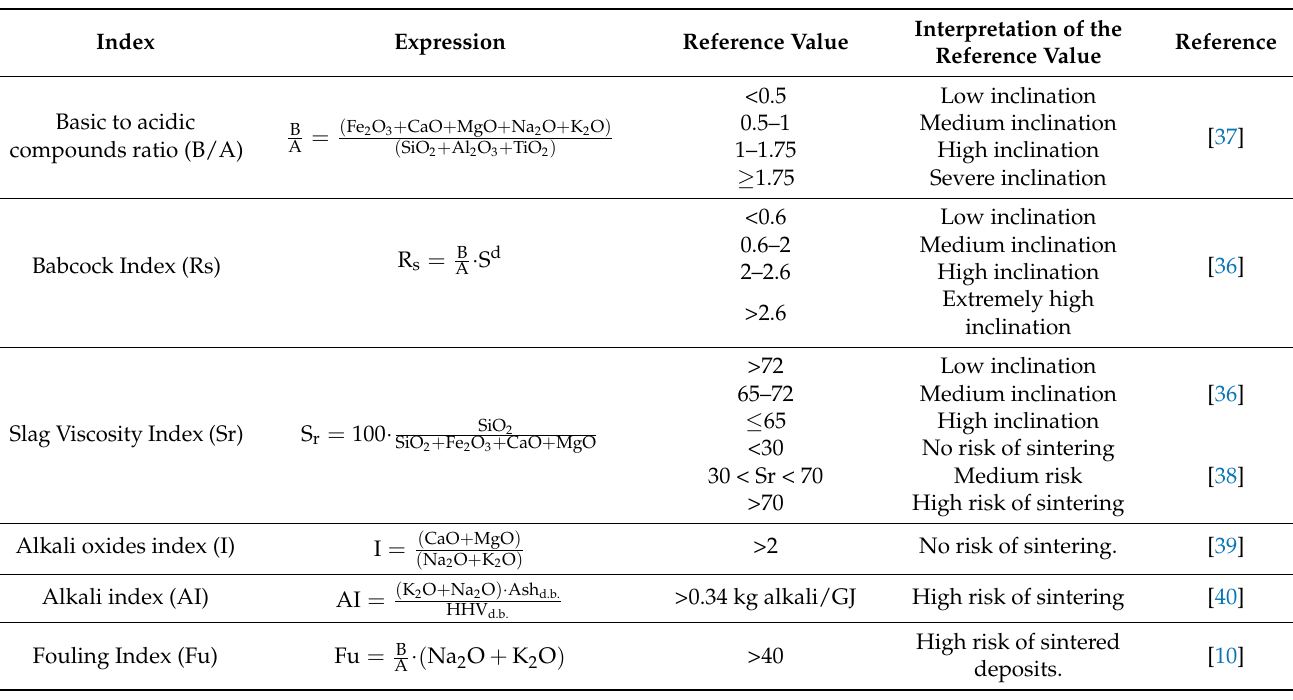
Table 4. Predictive indices for sintering.